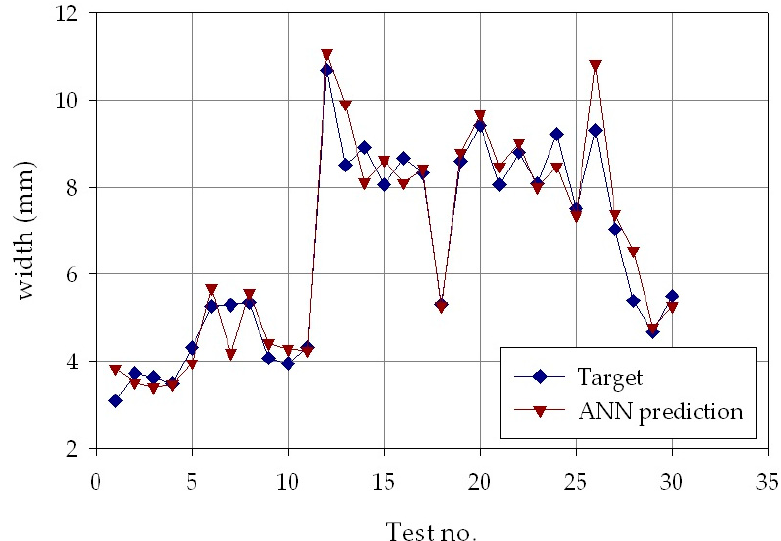
Figure 9. Experimental average (blue marks) and ANN estimated (orange marks) deposit width, w , for each of the p = 30 experimental conditions.